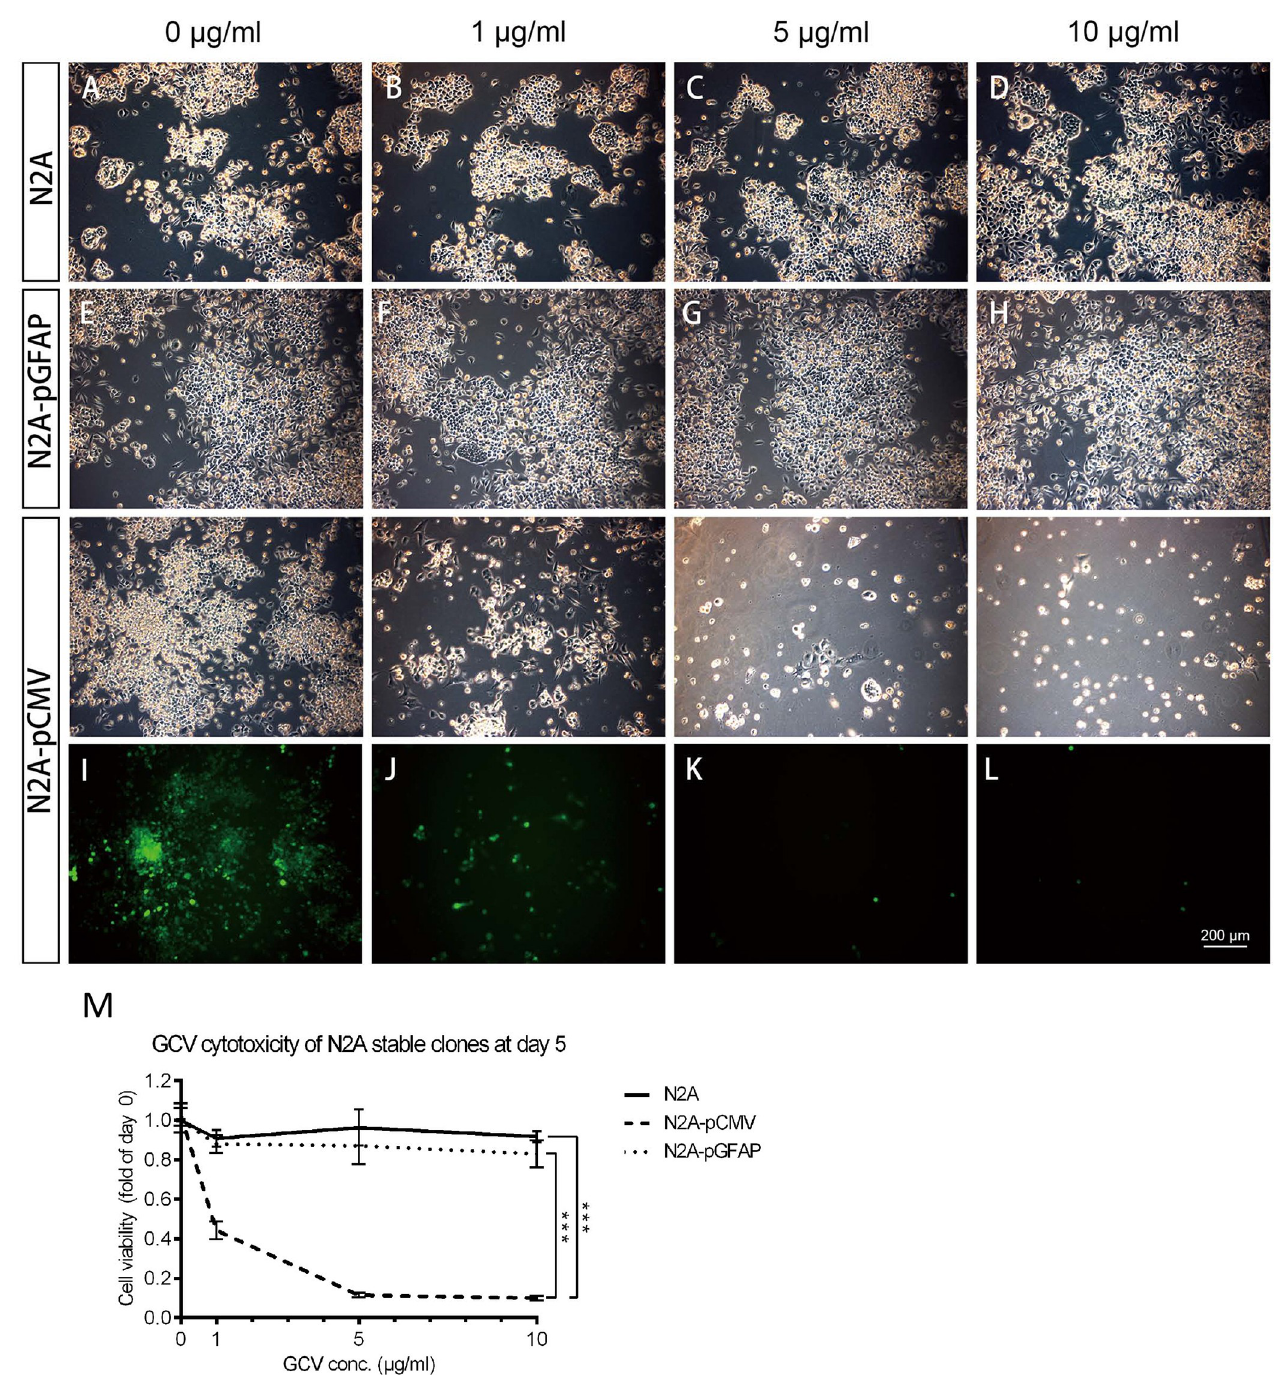
Fig 2. Sensitivity of N2A stable clones to GCV. (A–L) N2A, N2A-pGFAP-HSVtk, and N2A-pCMV-HSVtk cells were treated separately with 0, 1, 5, or 10 μ g/ ml of GCV for 5 days, and their live-cell phase images or fluorescent images were captured. (M) An MTT assay was performed to detect their cell viability under GCV challenge (n = 3). The morphology of N2A parent cells (A–D) and N2A-pGFAP-HSVtk cells (E–H) remained intact and their cell viability was maintained above 90%. (I–L) The number of N2A-pCMV-HSVtk cells was decreased in a dose-dependent manner. In addition, green fluorescent cells were still detectable among the surviving cells even after treatment with 10 μ g/ml of GCV. (M) The results of the MTT assay for these three groups were consistent with the imaging results. Scale bar, 200 μ m.